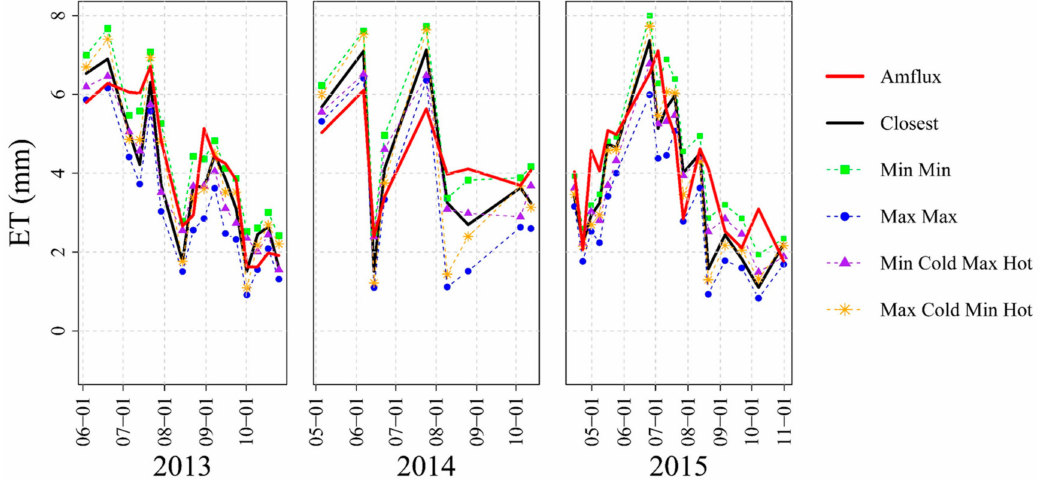
Figure 10. Comparison of 24-h ET computed using the selected five calibration schemes with eddy covariance flux tower data for 2014, 2015, and 2016. With any of these calibration sets, the temporal pattern of ET over the year is well captured. The line corresponding to “closest” presents results with the traditional method of anchor pixel selection (closest to the weather